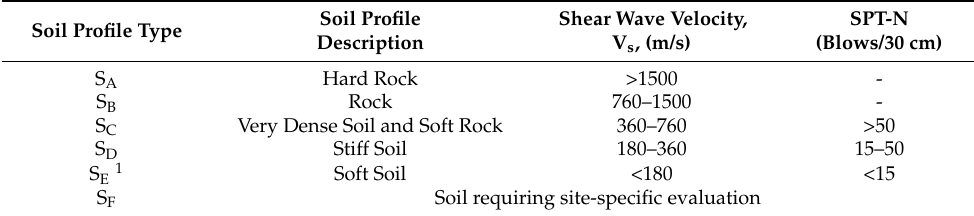
Table 4. Site classification scheme according to the National Structural Code of the Philippines, employing the V s30 metric to determine the general soil description and its typical corresponding